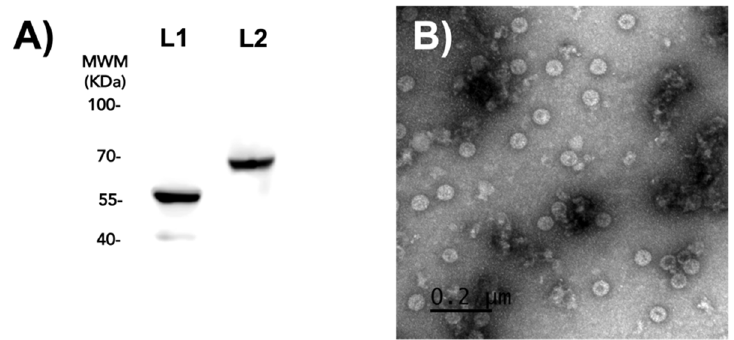
Figure 2. Characterization of PsVs. ( A ) HPV16 PsV immunoblotting. Purified PsVs were elec- trophoresed by SDS-PAGE and immunoblotted against HPV16 L1 and L2 protein monoclonal anti- bodies. Prominent 55 and 70 KDa bands corresponding to the L1 and L2 monomer confirmed the purity of PsVs. MWM, molecular weight marker. ( B ) Negative-stain TEM microphotography of PsVs (scale bar = 200 nm).